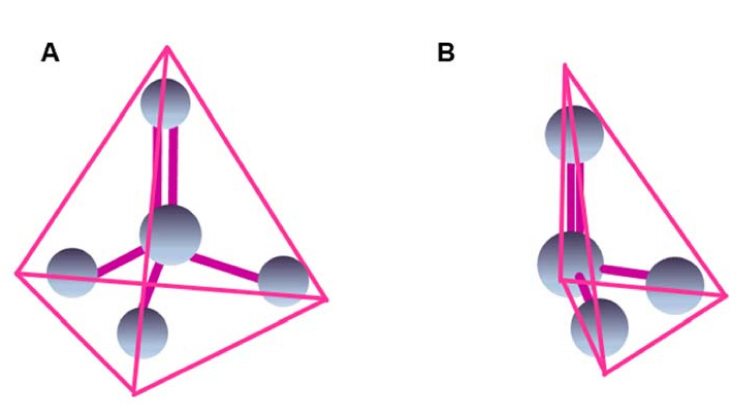
Figure 3. Tetrahedral ( A ) and trigonal pyramid ( B ) arrangements of phosphate and selenite ( A ) and selenite ( B )